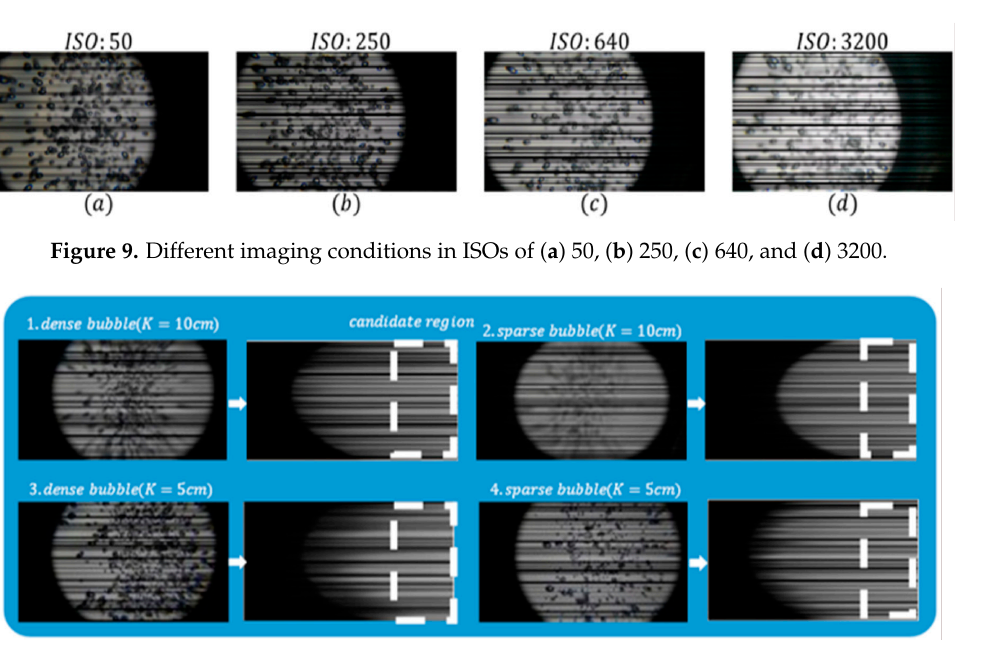
Figure 10. Performance of the proposed method in different bubbly environments.